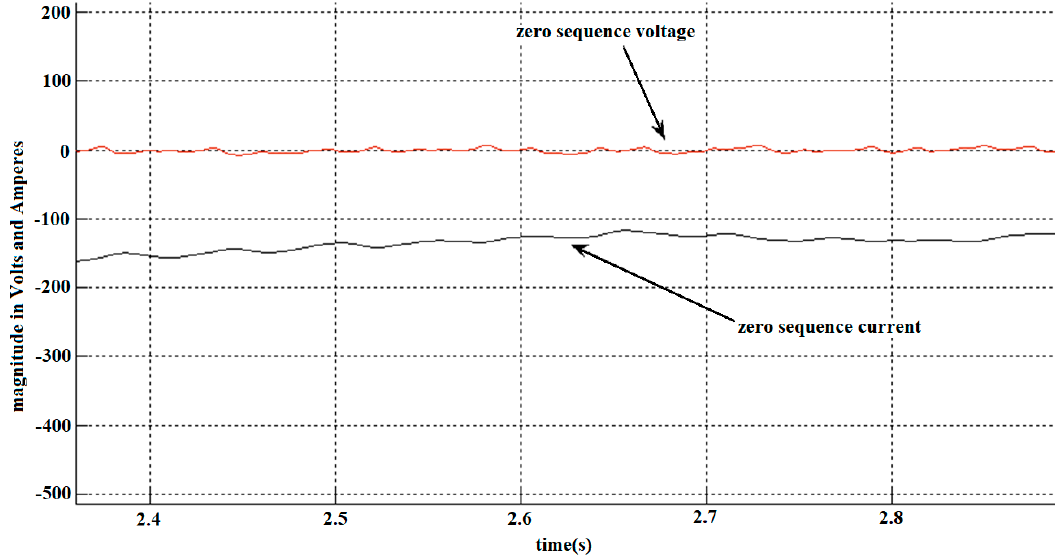
Figure 21. Zero sequence voltage and current waveforms.